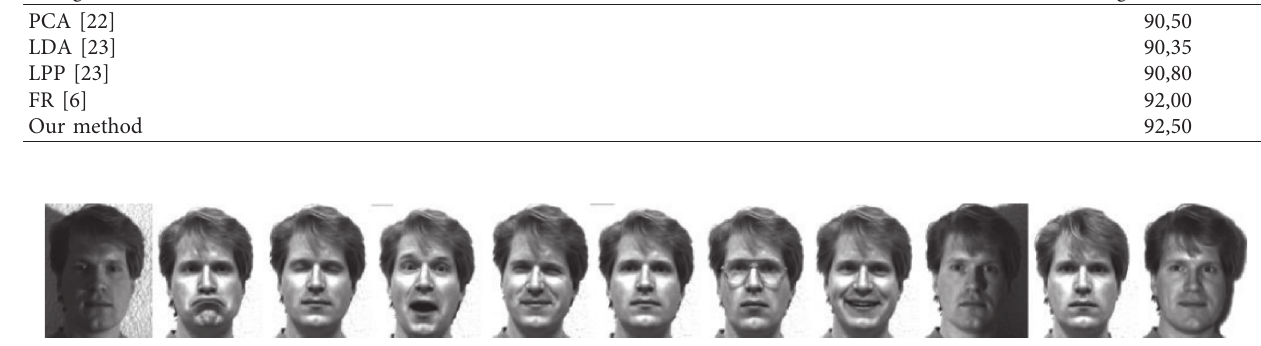
Figure 8: Eleven images of a person extracted from the Yale database. Table 4: Recognition rates (%) of the proposed method and different approaches on the Yale database.